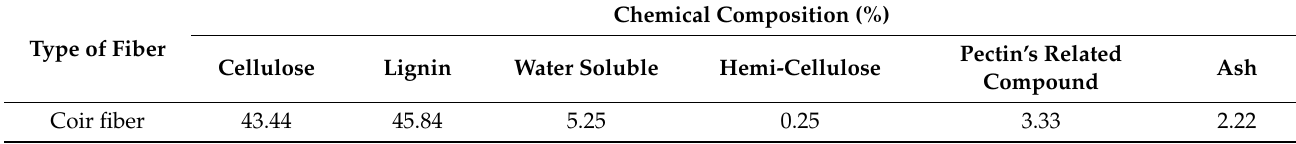
Table 2. Chemical composition of coir fiber [34,35].